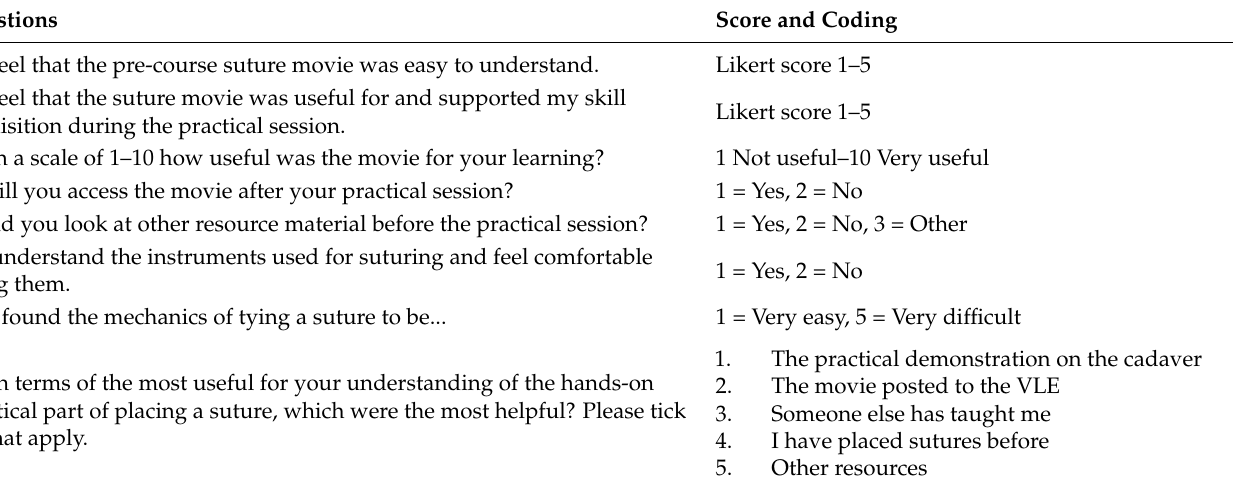
Table 1. The questions and coding for the student questionnaire omitting free text